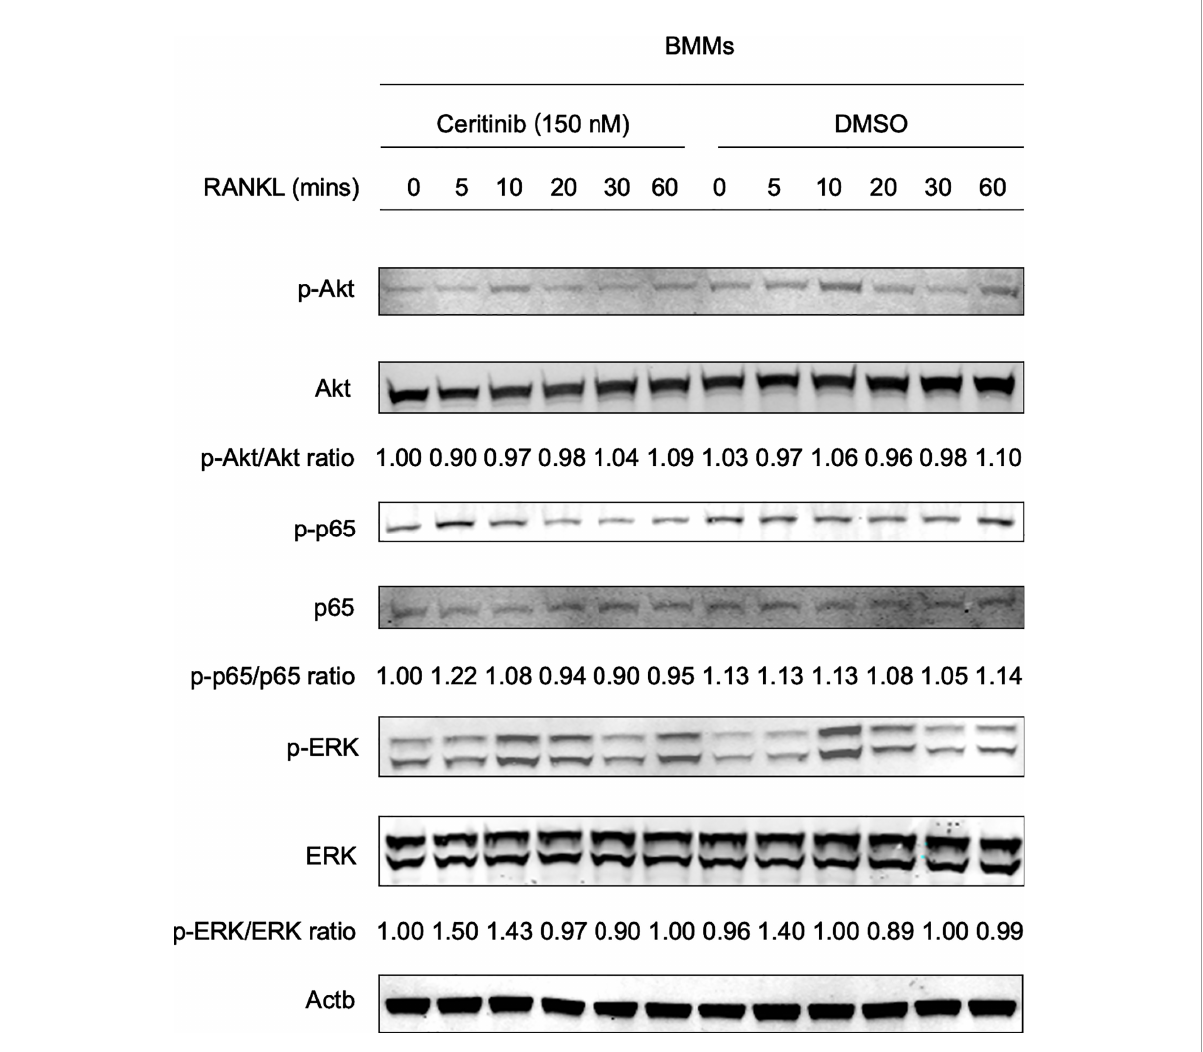
FIGURE 3 Molecular mechanisms of ceritinib in RANKL-mediated osteoclastogenesis. The status of different signaling pathways during RANKL-induced osteoclastogenesis: ceritinib inhibited the activation of phospho-Akt (Ser473) and phospho-p65. However, there was no signi fi cant change in ERK